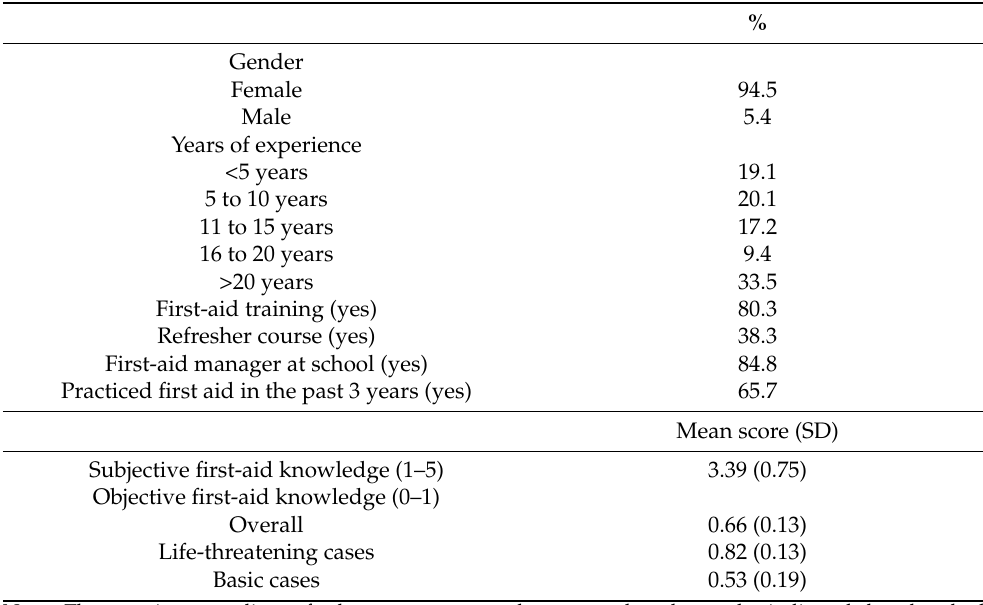
Table 1. Overview of the study sample (N =